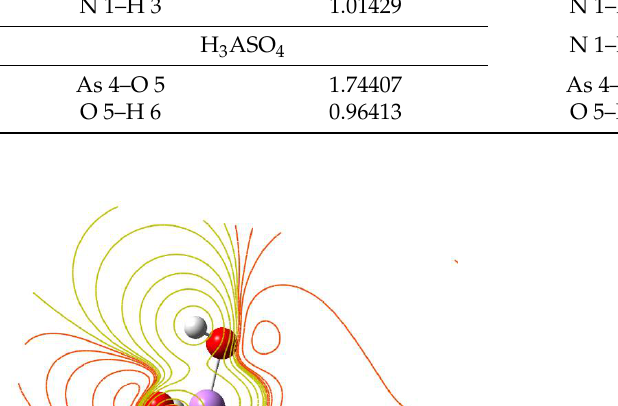
Table 5. Selected structural parameter of optimized geometries on bond length.